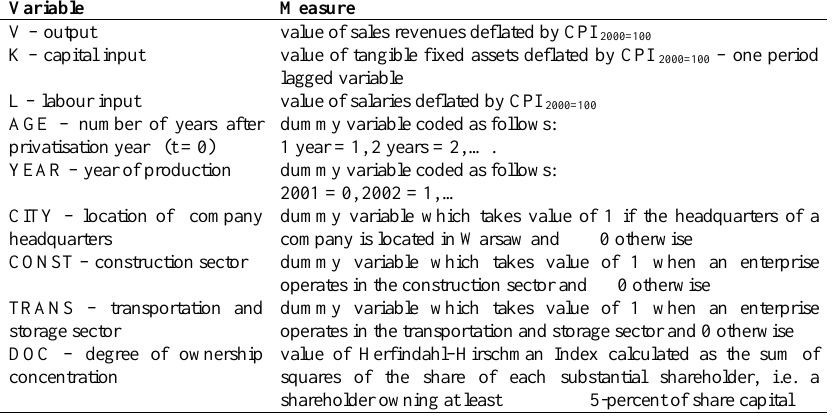
Table 2. Description of variables used in the estimation of a Cobb – Douglas production